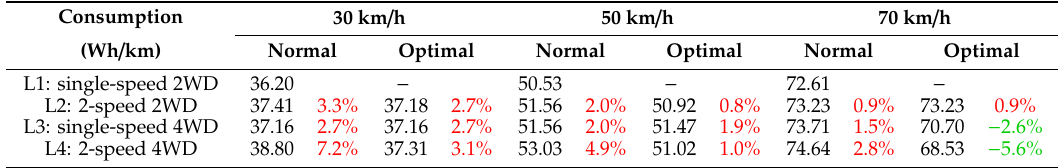
Table 5. Energy consumption results at constant speed, and their percentage di ff erence with respect to those of the single-speed 2WD EV (L1); positive di ff erences, implying higher consumption, are in red, while negative di ff erences are in green.